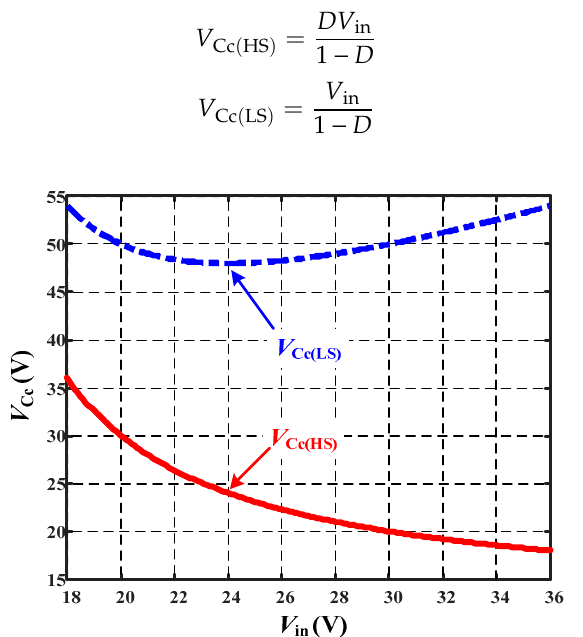
Figure 2. Comparison of the clamp capacitor voltage for different clamp circuit.